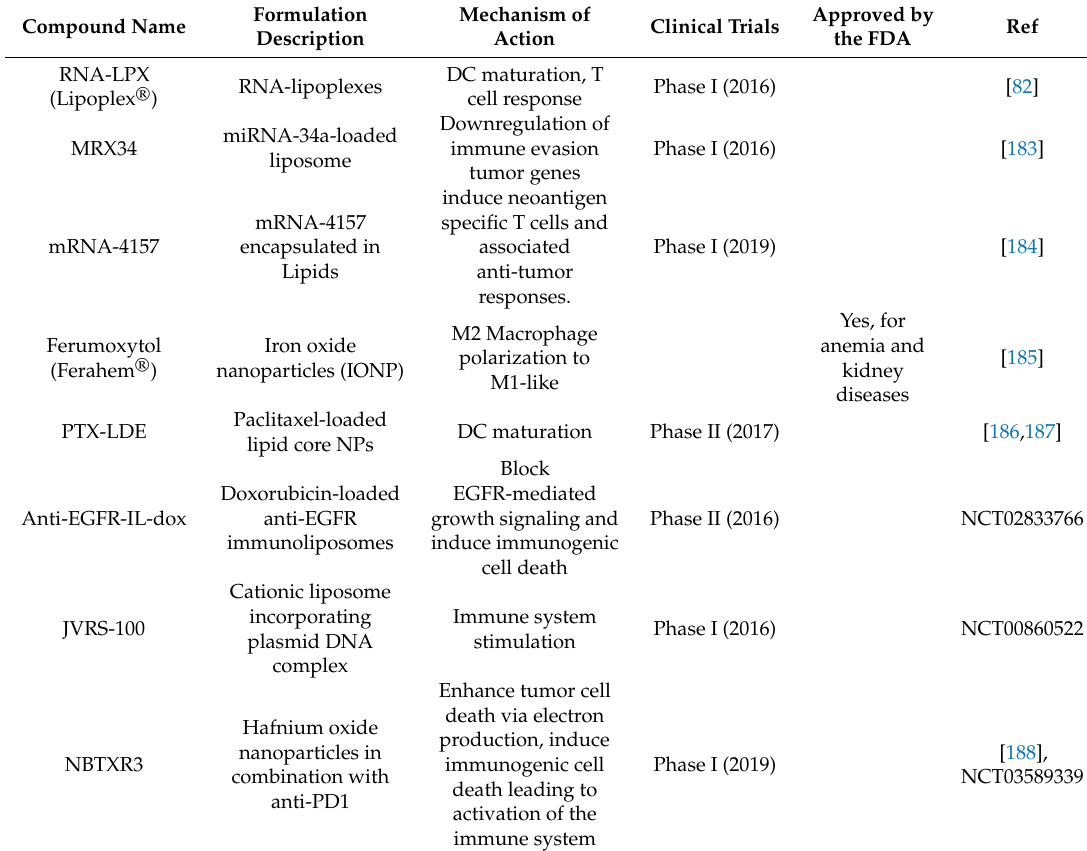
Table 1. FDA approved nano-Immunotherapy and studies under clinical trials to treat cancer